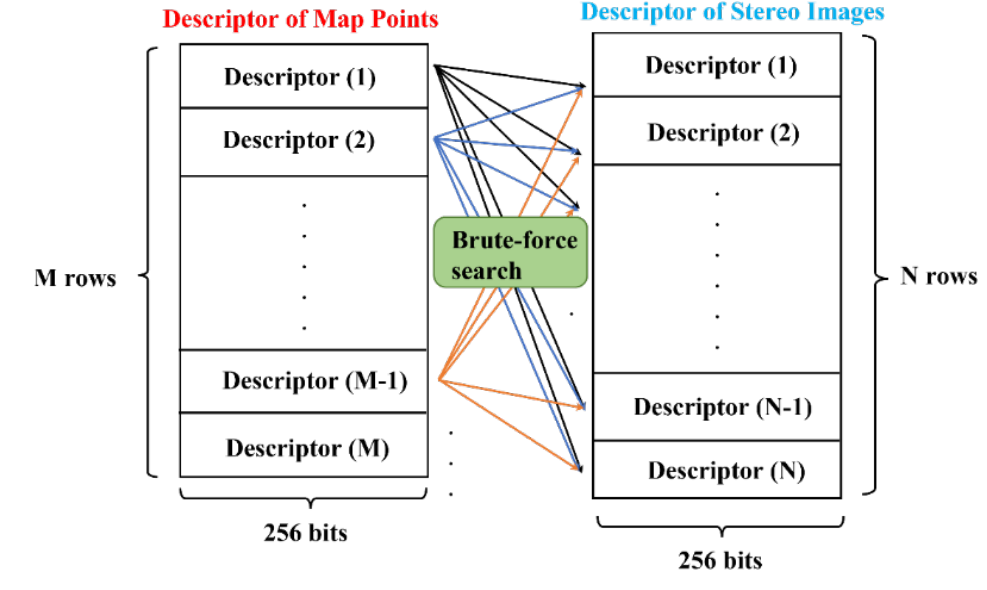
Figure 7. Brute-force feature matching.